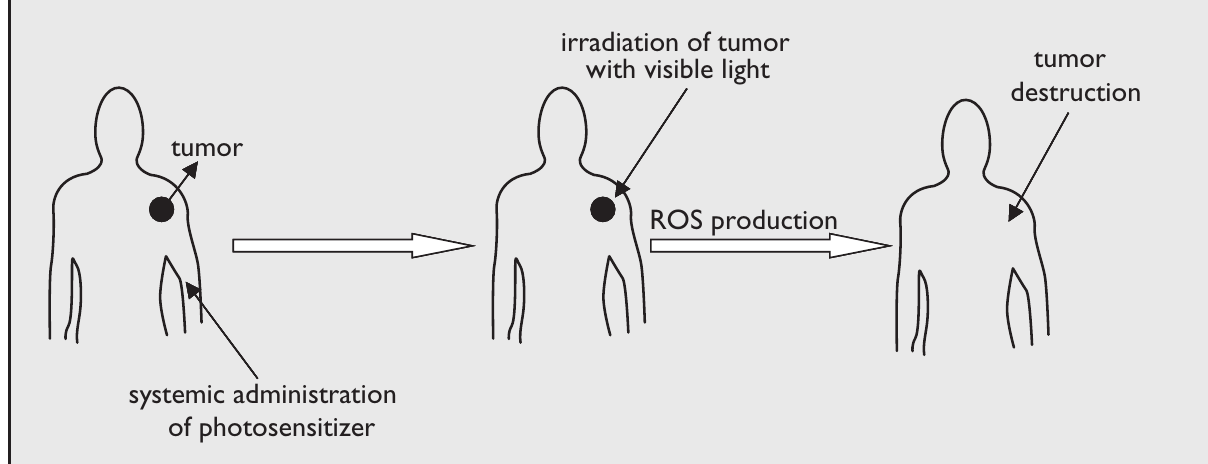
Figure 2 – Schematic of tumor therapy using a photosensitizing drug and visible light